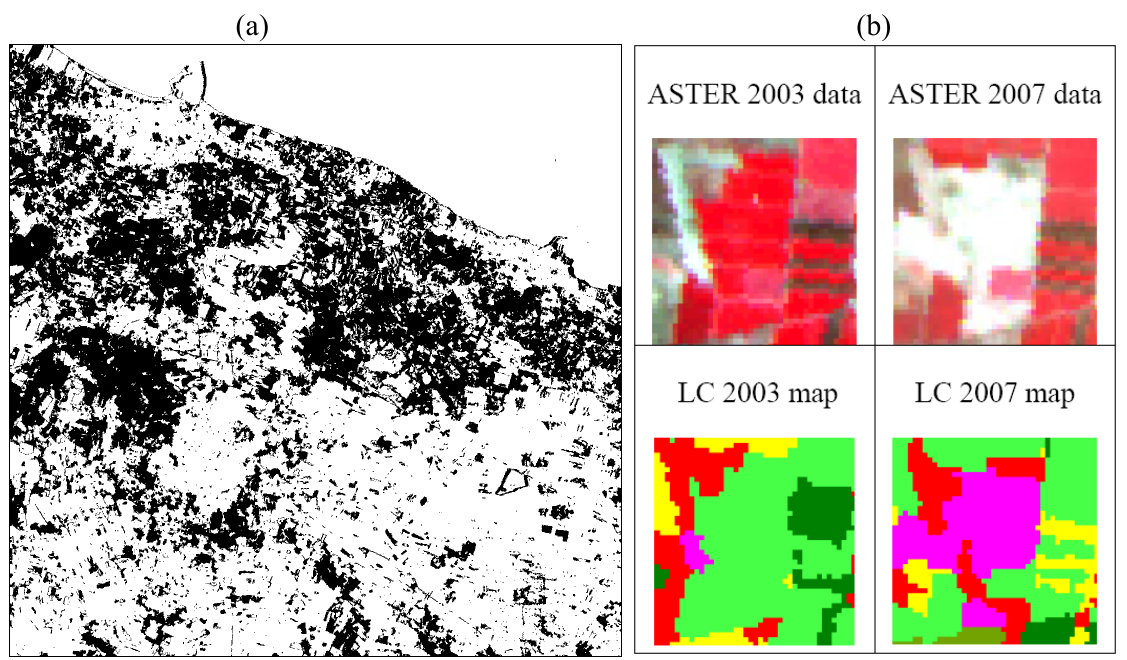
Figure 6. (a) Image difference resulting from post-classification comparison of two independently classified images (Black-Change, White-No Change); (b) Subset area of land cover transformations identified on ASTER 2003 and 2007